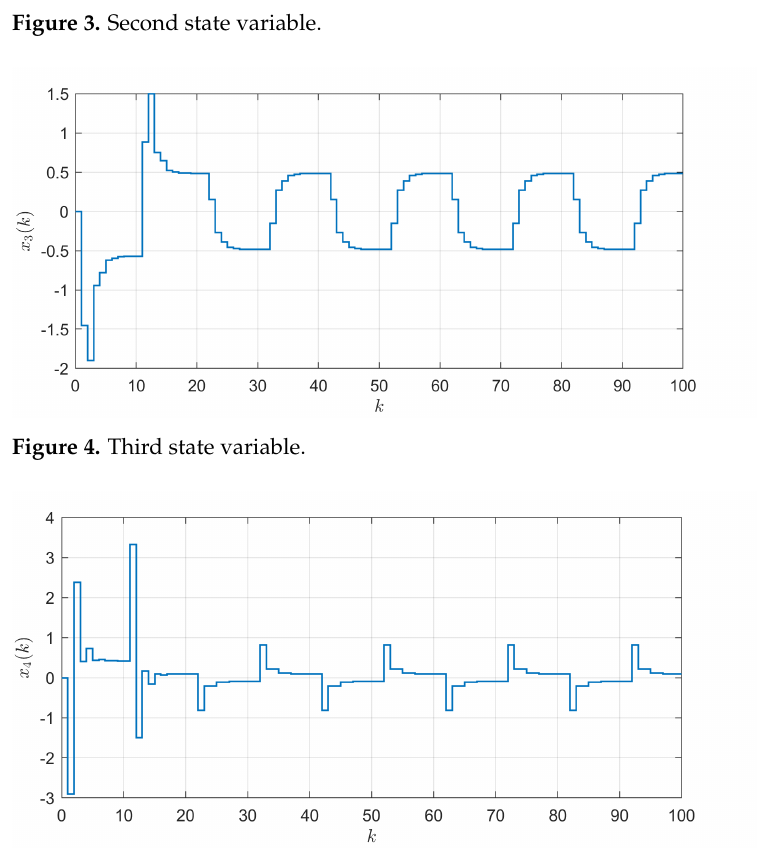
Figure 5. Fourth state